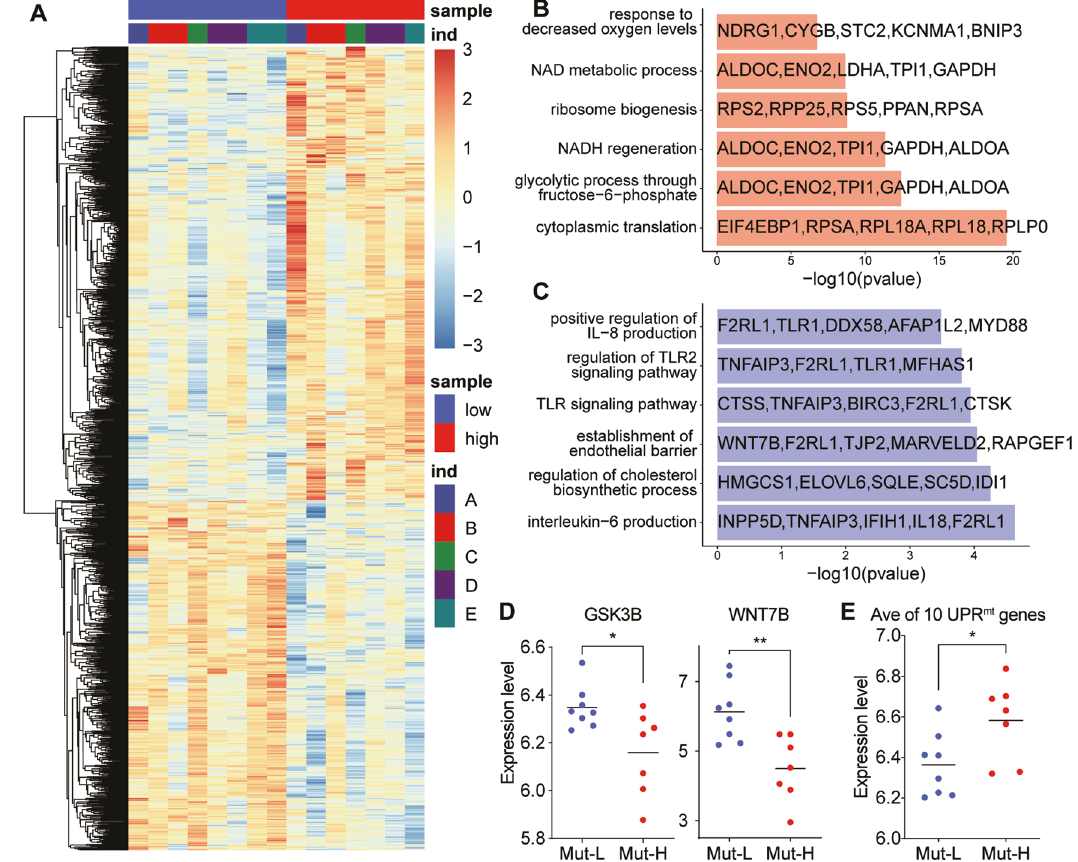
Fig. 3 Different transcriptional pro fi les between Mut-H and Mut-L USCs. A Heatmap of whole transcriptome data showing different gene transcription from Mut-H to Mut-L USCs. B Gene ontology (GO) analysis exhibit different enrichment of gene families in Mut-H USCs. C Gene ontology (GO) analysis exhibit different enrichment of gene families in Mut-L USCs. D GSK3B and WNT7B mRNA expression decreased in Mut- H USCs. E A panel of ten genes related to UPR mt was found to express higher in Mut-H USCs. * P < 0.05, ** P <